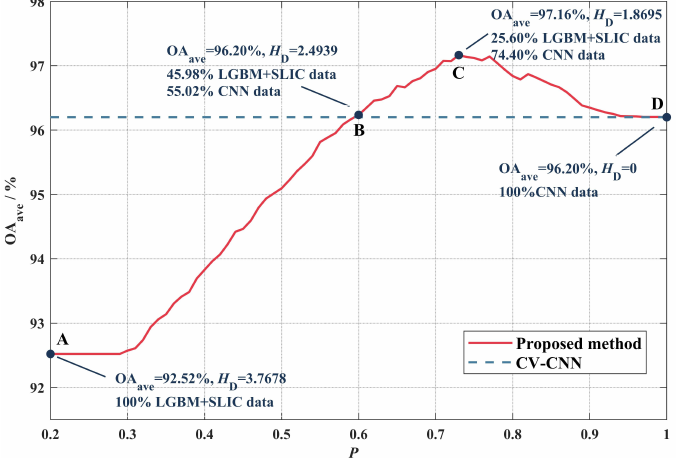
Figure 8. OA ave - P m curve. The curve shows the average OA with different numbers of superpixels when the number of superpixels, k , ranged from 244 to 750. The percentage of data represents the proportion of LGBM+SLIC and CV-CNN data used by our proposed method in the test